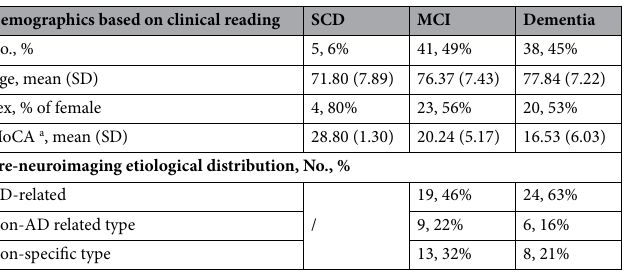
Table 3. Demographics and clinical diagnosis at initial analysis prior to MRI and 18F-Flutemetamol PET imaging. a MoCA: Dementia < MCI, p < 0.05; Dementia < SCD, p < 0.0001; MCI < SCD, p <